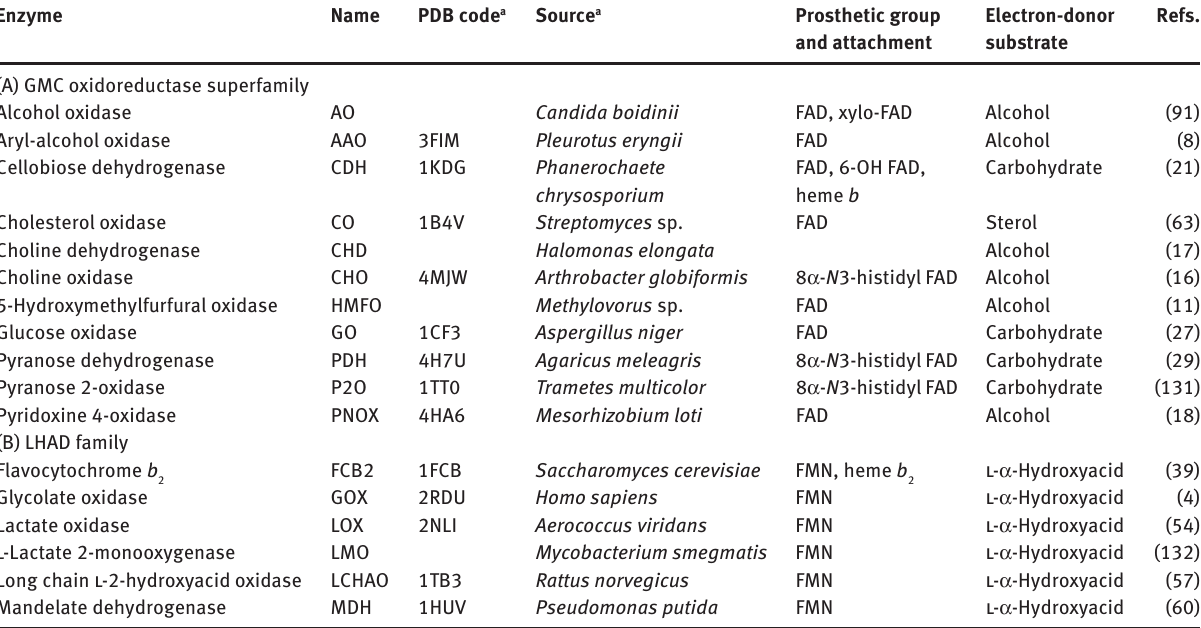
Table 1 GMC and LHAD enzymes that oxidize